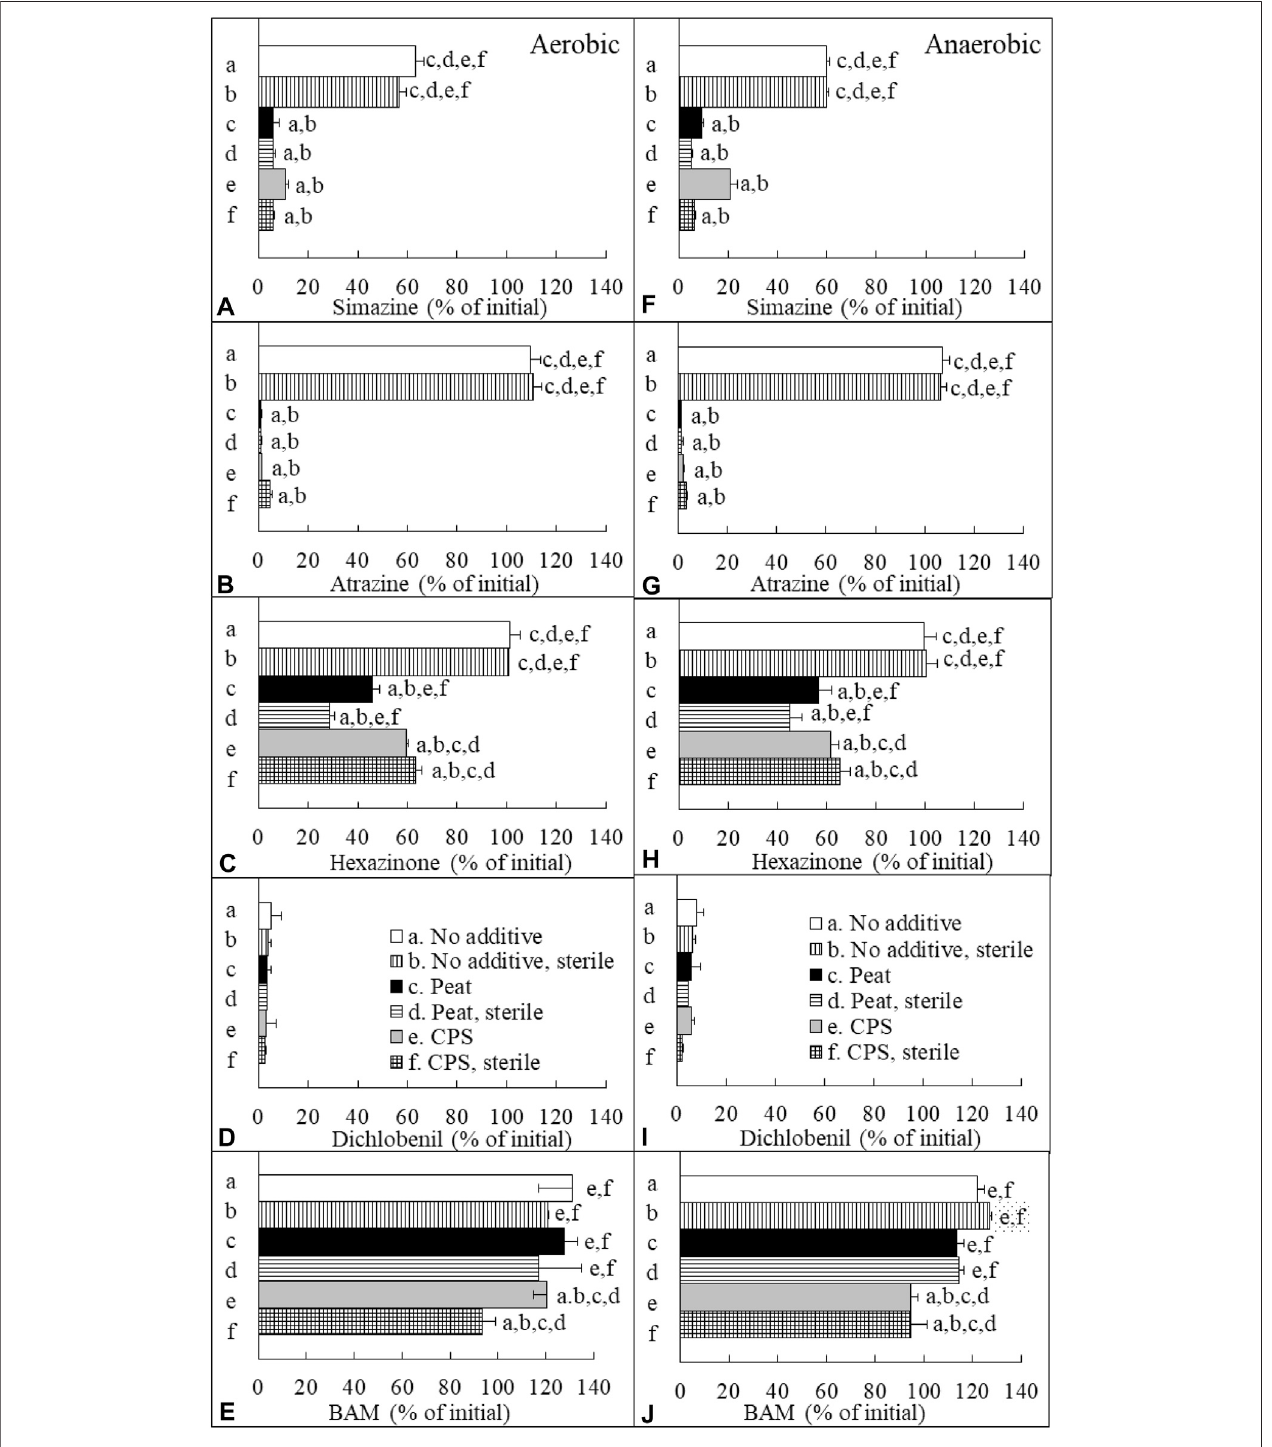
FIGURE 3 | (A) Simazine (B) atrazine (C) hexazinone (D) dichlobenil and (E) 2,6-dichlorobenzamide (BAM) concentrations as % of the initial in the groundwater sedimentslurriesunderaerobicconditions; and (F) simazine (G) atrazine (H) hexazinone (I) dichlobenil and (J) 2,6-dichlorobenzamide(BAM)concentrationsas%ofthe initial in the groundwater sediment slurries under anaerobic conditions. (a) Slurries without additives, (b) sterilized slurries without additives (c), slurries with peat (d) sterilized slurries and peat, (e) slurries with CPS, (f) sterilized slurries and CPS. The error bars indicate standard deviations (n (cid:2) 3), and the letters next to the bars show statistically signi fi cant differences (Kruskal-Wallis test followed by Mann-Whitney ’ s test).